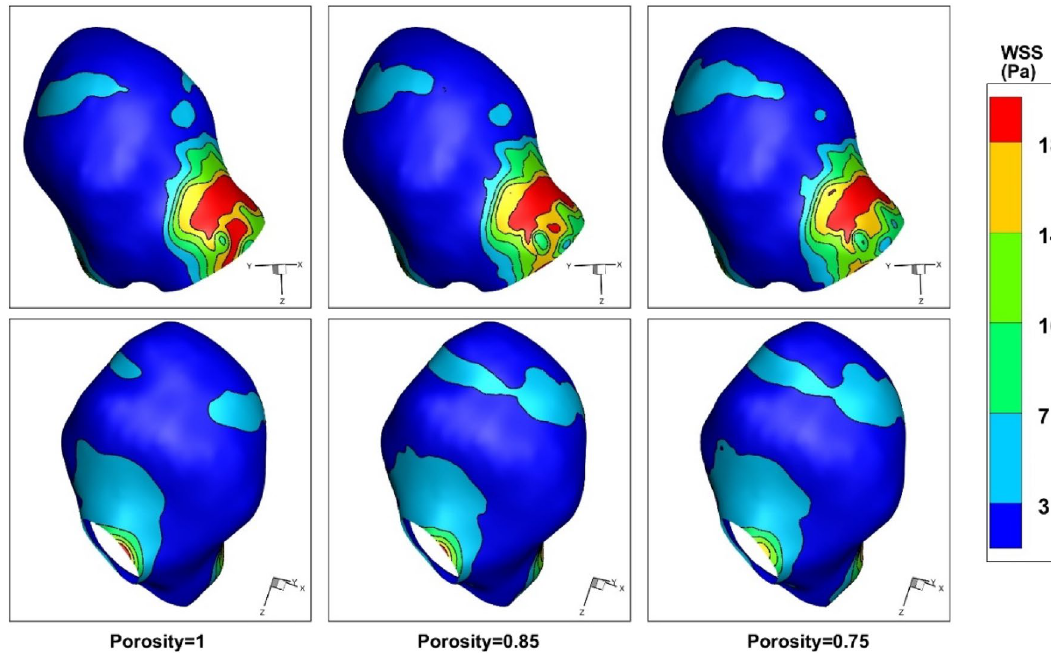
Figure 9. Effects of coiling porosity on WSS at peak systolic.